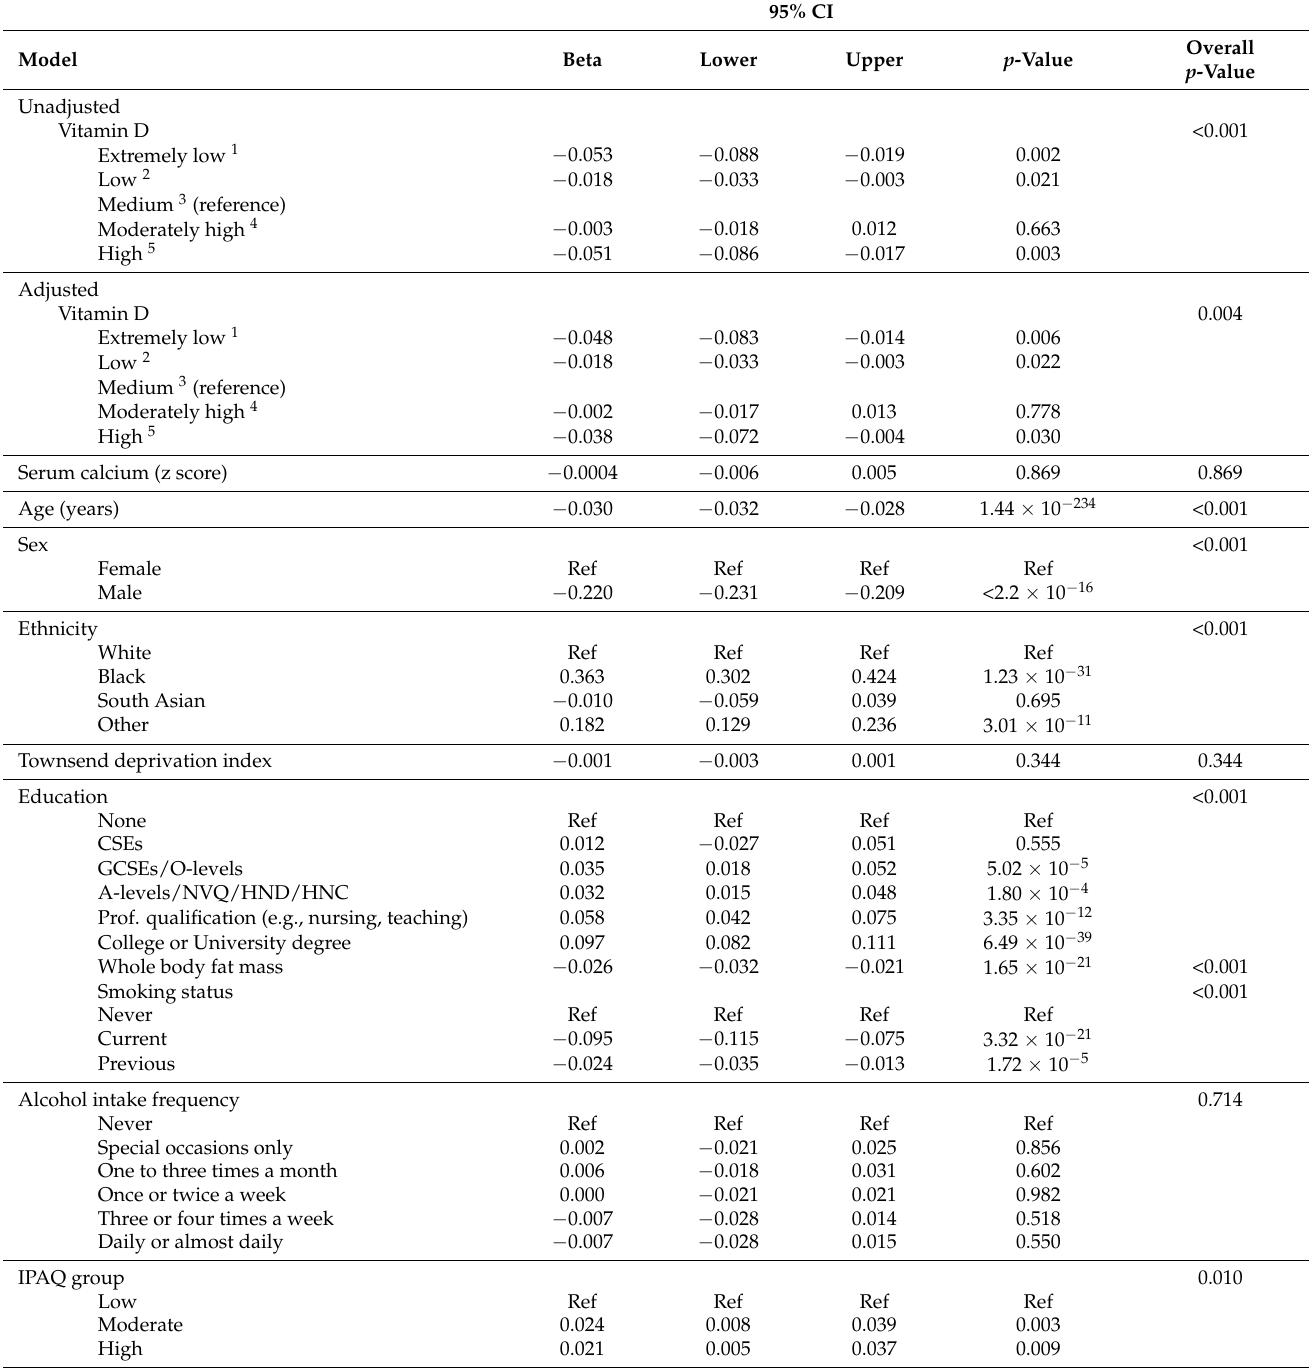
Table 3. Association between vitamin D and leukocyte telomere length, unadjusted and adjusted for